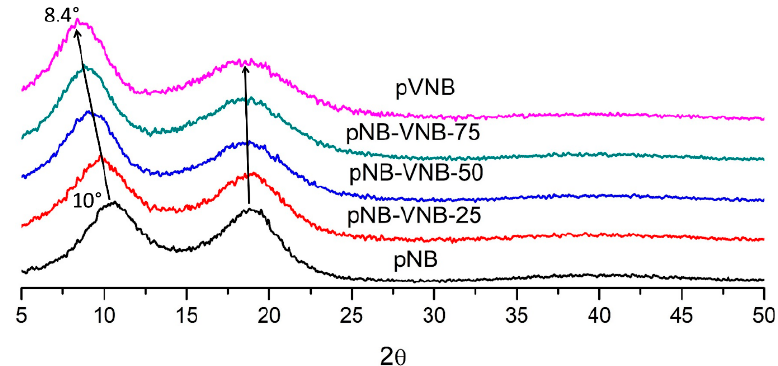
Figure 6. Normalized WAXS spectra of polynorbornenes with increasing VNB content.